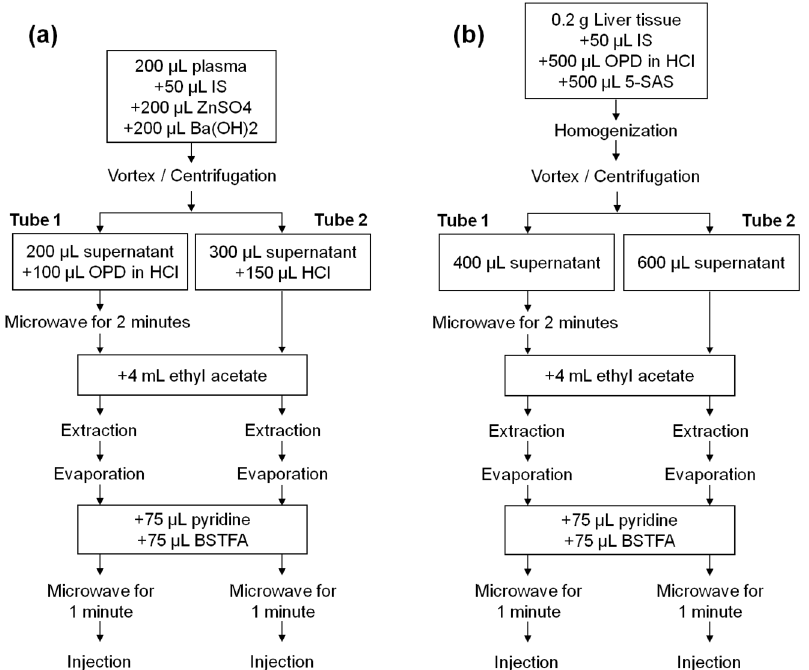
Figure 4. ( a ) Schema of the assay procedure for the determination of lactate and pyruvate (Tube 1) and β -hydroxybutyrate and acetoacetate (Tube 2) in plasma samples. ( b ) Schema of the assay pro- cedure for determination of lactate and pyruvate (Tube 1) and β -hydroxybutyrate and acetoacetate (Tube 2) in liver samples. 5-SAS: 5-sulfosalicylic acid; BSTFA: bis(trimethylsilyl)trifluoroacetamide; HCl: hydrochloric acid; IS: internal standard; OPD: